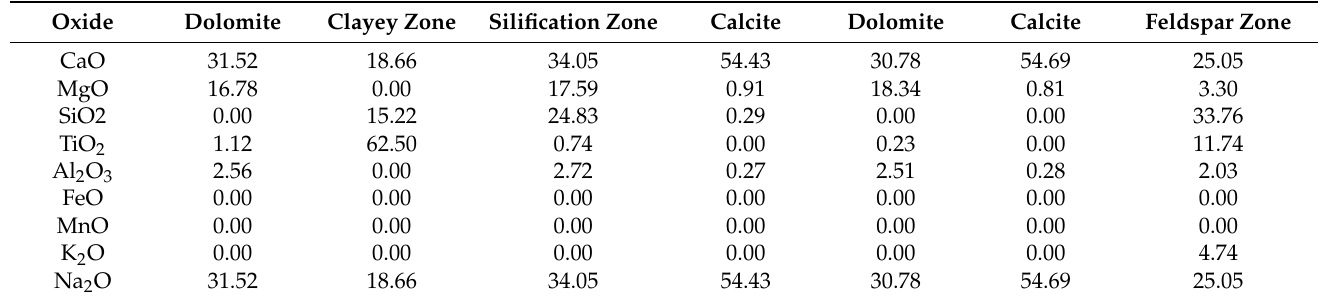
Table 4. Chemical composition of minerals of organogenic dolomitic limestone samples taken from the borehole core, wt. %. Oxide Dolomite